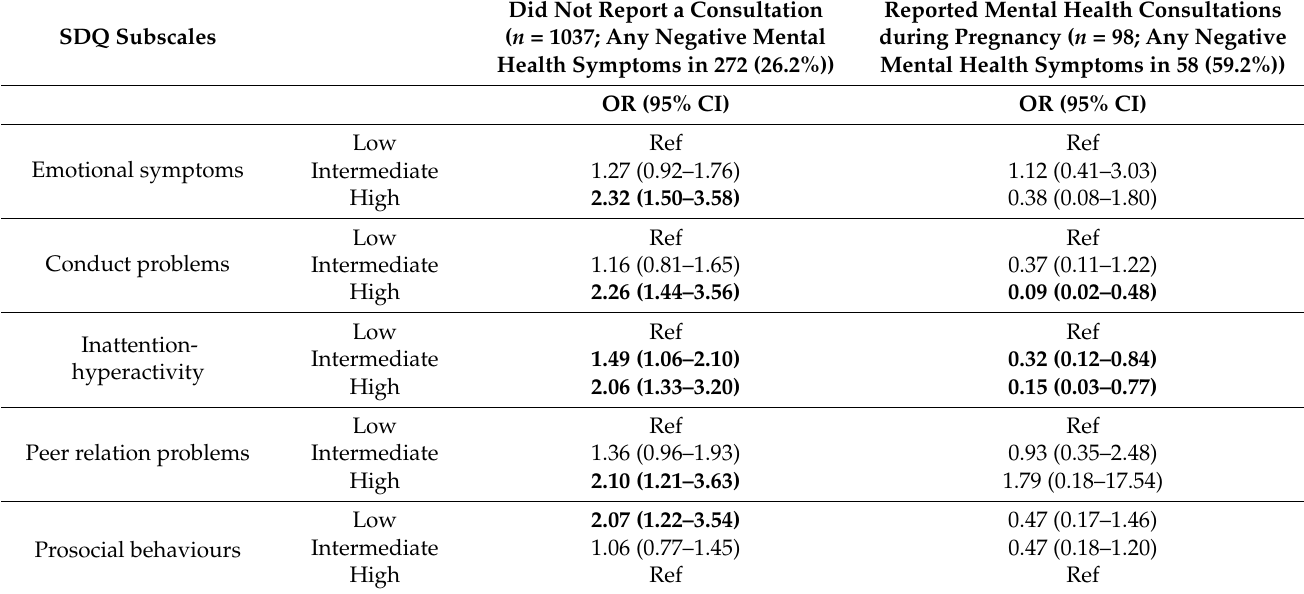
Table 3. Stratified analysis by consultations with a psychologist or psychiatrist during pregnancy or not). IPW-adjusted multinomial regressions comparing associations between exposure to any prenatal negative mood symptoms and odds of following intermediate and high trajectories of emotional and behavioural problems in both groups. In both analyses, the children with no exposure to negative mental health symptoms are taken as a reference